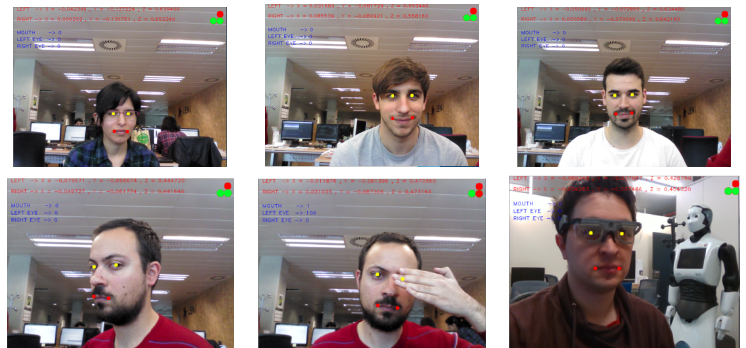
Figure 9. Qualitative results visualisation of the estimated mouth pose with five users. Red points are the mouth landmarks and yellow points the pupil landmarks. The top-right circles indicate if the user has their mouth or the eyes open (green) or closed (red) (best viewed in colour).